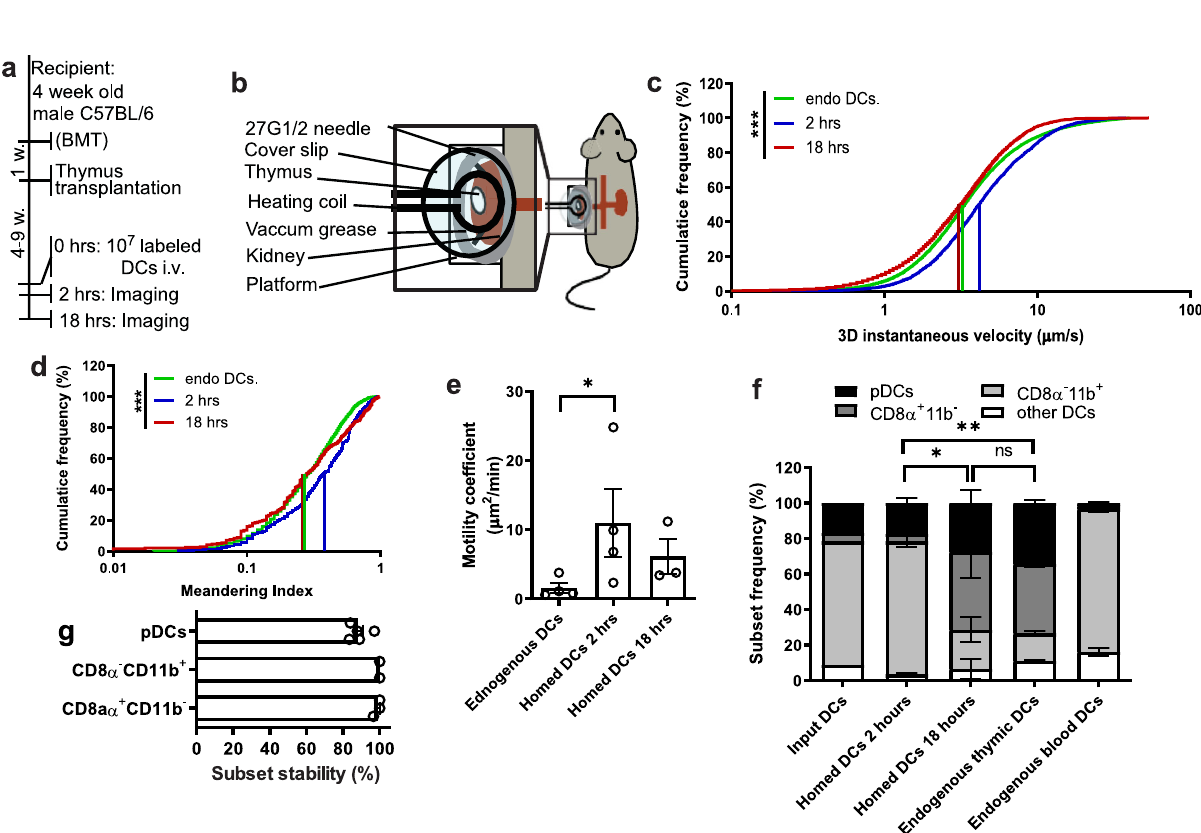
Fig. 2 Analysis of dendritic cells in endogenous and transplanted thymi. a Experimental protocol for thymic MP-IVM experiments. BMT: bone marrow transplantation. b Schematic drawing of the experimental setup to image transplanted thymi by MP-IVM. c 3D instantaneous velocity and d meandering index of thymus-resident DCs and homed DCs at 2 hours and 18 hours post transfer. n = 3 independent experiments. e Motility coef fi cients of endogenous and homed DCs. n = 4 independent experiments for 2 hrs and n = 3 independent experiments for 18 hrs time points. f Subset composition of resident thymic DCs and homed DCs 2 and 18 h post transfer. n = 2 experiments with 10 mice/group. g FACS-sorted splenic DC subsets were fl uorescently labeled and injected IV into recipient mice. 18 h later, subset-speci fi c markers on homed DCs in recipient thymi were analyzed by fl ow cytometry. DC subsets were sorted as follows: pDCs: CD11c + PDCA1 + B220 + ; CD8 α + CD11b – DCs: CD11c high PDCA1 – B220 – CD8 α + CD11b – ; CD8 α – CD11b + DCs: CD11c high PDCA1 – B220 – CD8 α + CD11b – . n = 5 mice/group. Bars and error bars represent mean ± SEM. Statistical comparisons were performed using two-way ANOVA unless stated otherwise. * P = 0.0428 ( e ) and P = 0.0142 ( f ); ** P = 0.0026, *** P < 0.001; n.s. not signi fi cant. DCs dendritic cells, pDCs plasmacytoid dendritic cells. See also Supplementary Fig. 1 and Supplementary Movies 1 and which individual cells could be readily identi fi ed and tracked; this was not feasible when all thymic DCs carried YFP because at a 1:1 ratio (Fig. 2a). The transplanted animals generated a fl uorescent signals from individual cells became con fl uent and did dense network of thymic DCs among which a fraction could be not permit a clear delineation of cell – cell borders. The BM chi- visualized owing to their expression of yellow fl uorescent protein meric animals were rested for one week and then received thymus (YFP). The rationale for diluting CD11c-YFP donor BM with WT transplantation followed by MP-IVM 4 – 9 weeks later. To BM was to adjust the frequency of fl uorescent DCs to a density at